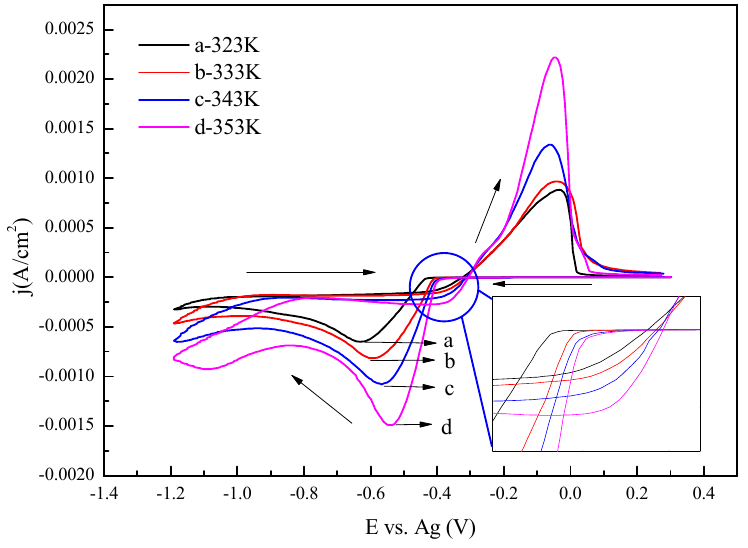
Figure 2. CVs with different temperature in ChCl–urea containing 0.2 M SnCl 2 at 50 mV/s.